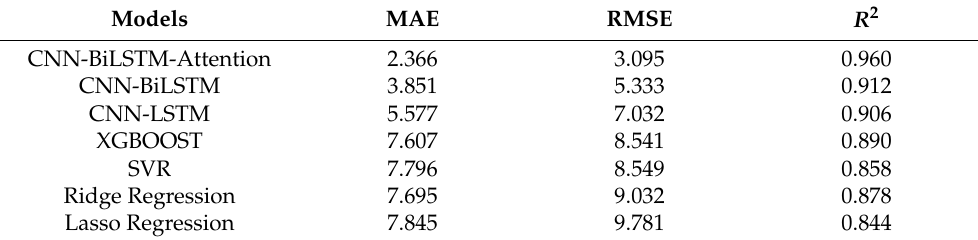
Table 5. MAE, RMSE (Unit: µ g/m 3 ), and R 2 of the proposed model and the comparison model.